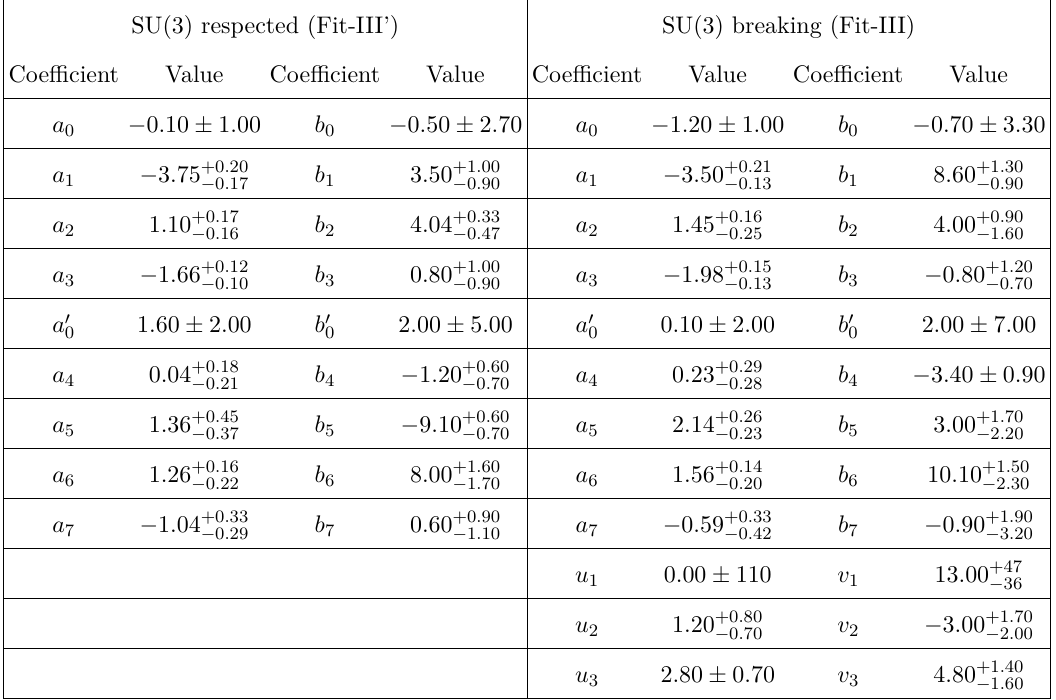
Table 5 . The fitting results of amplitude coefficients in irreducible amplitude approach (see eq. (2.4) and (2.6)) in the unit of 10 − 2 G GeV 2 F